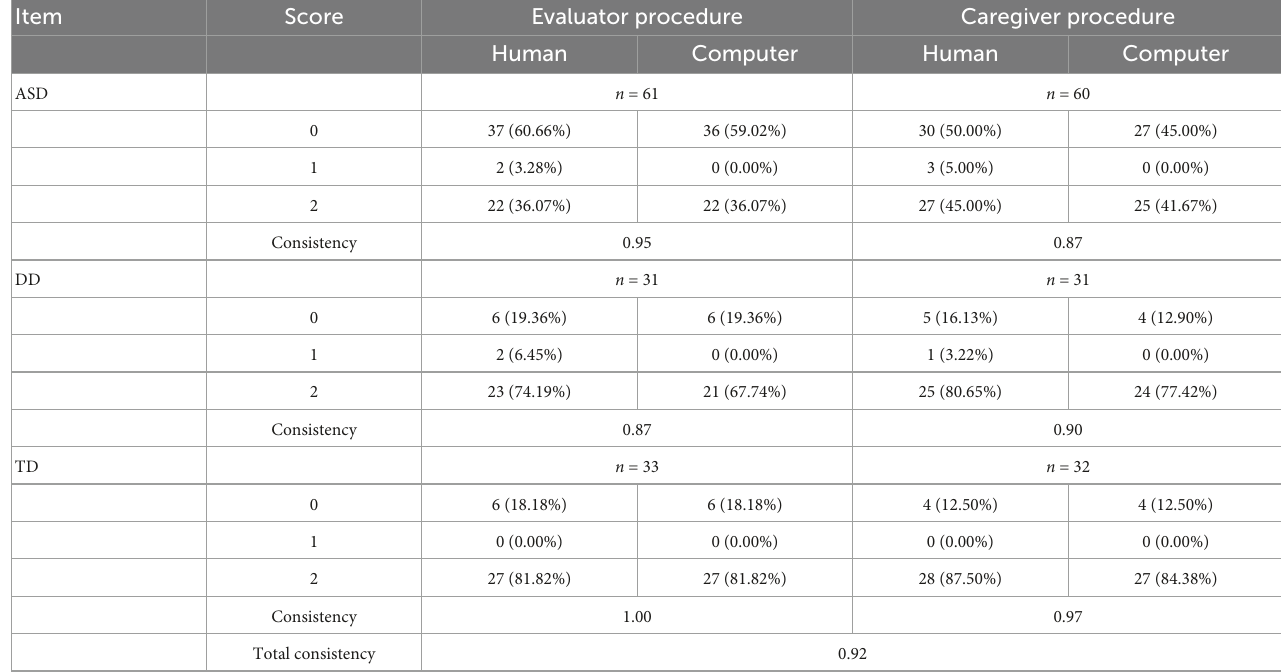
TABLE 1 Consistency of human and computer rating.